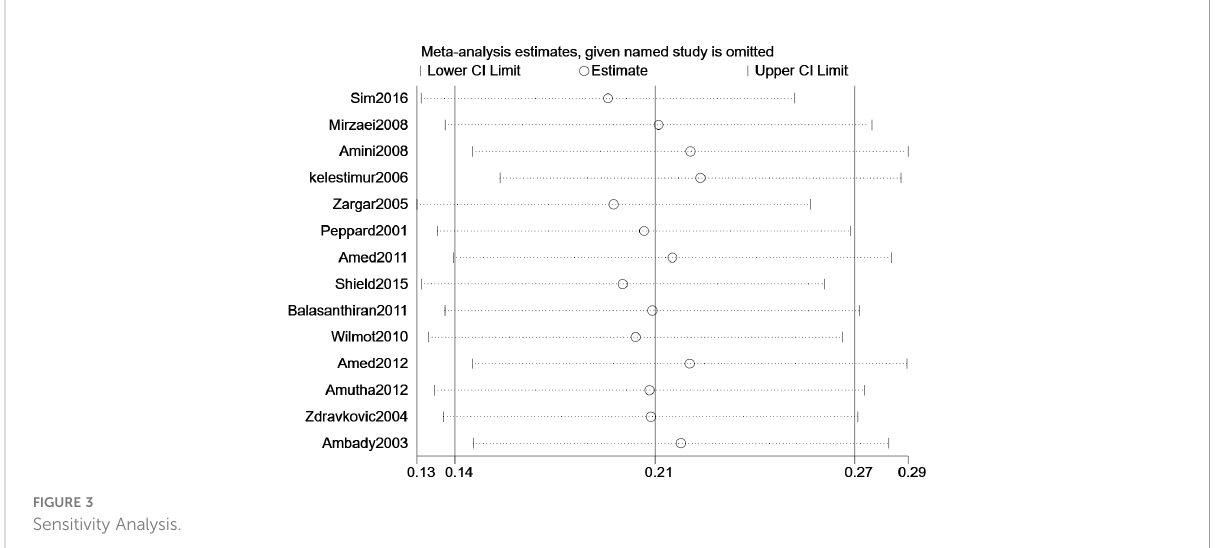
FIGURE 3 Sensitivity